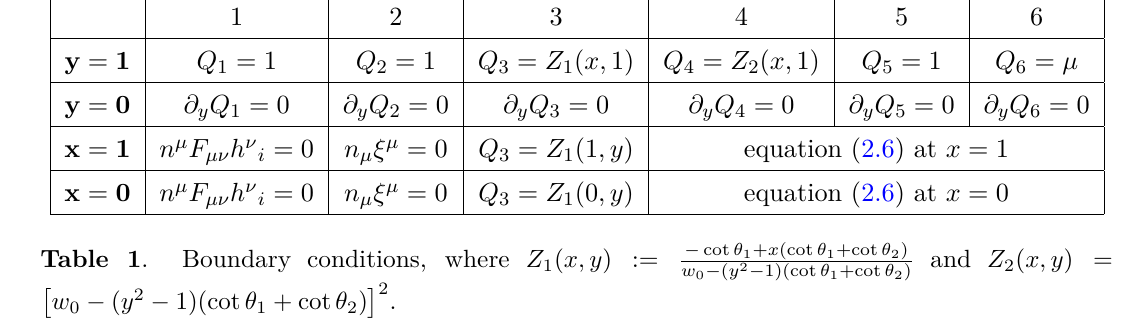
Table 1 . Boundary conditions, where Z 1 ( x, y )